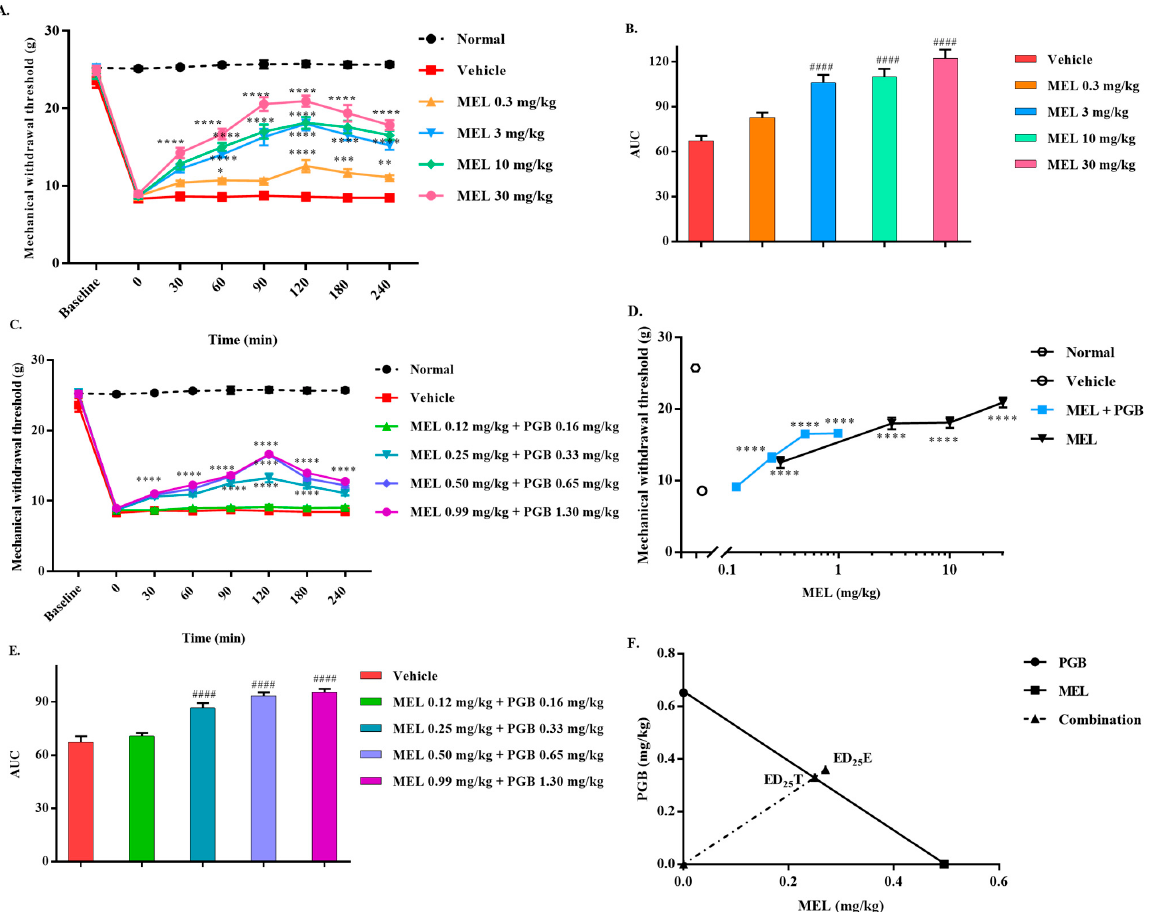
Figure 5. Effect of MEL, PGB, and MEL-PGB on carrageenan-induced mechanical allodynia. Time course effects on the MWT produced by administration of MEL in rats ( A ). The AUC data show